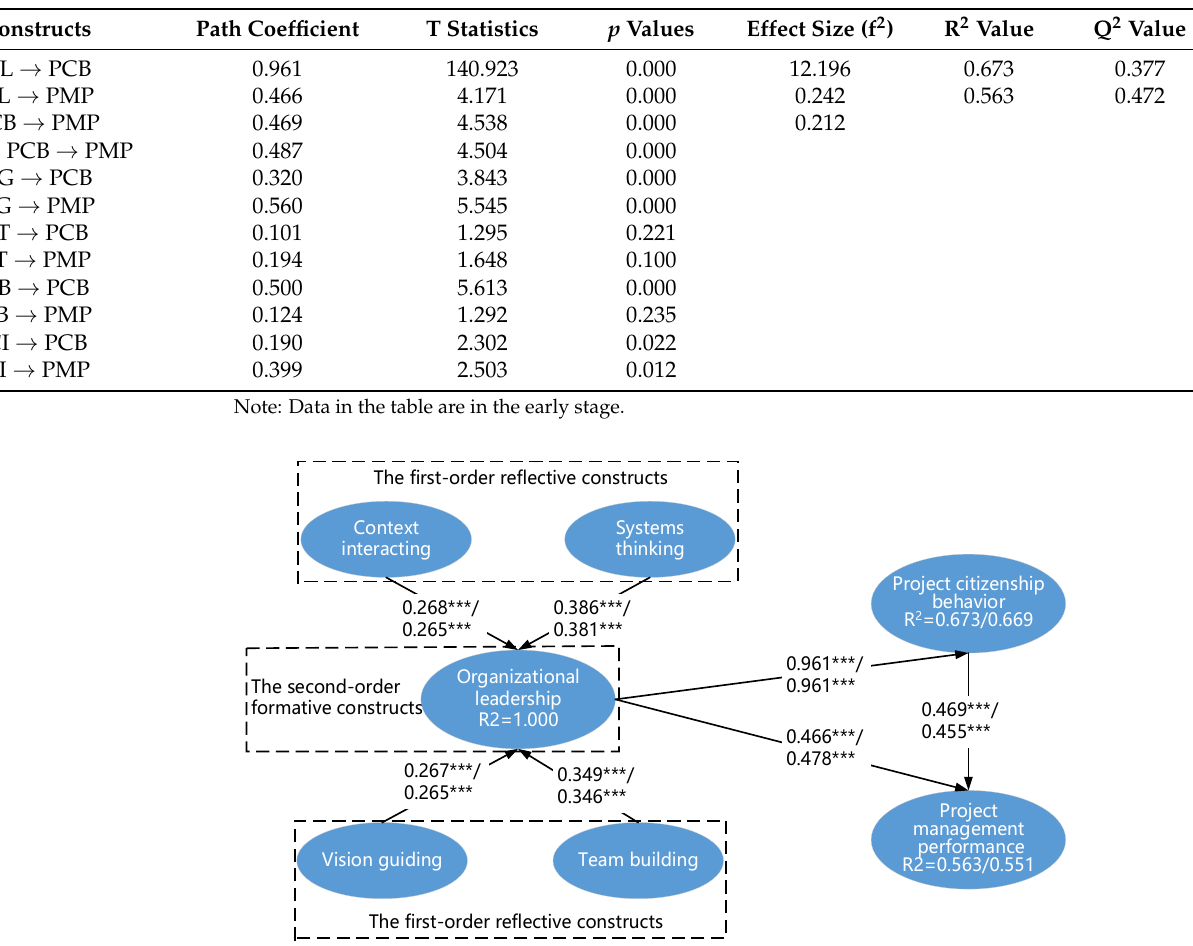
Figure 4. The structural model with analysis results. Notes: The early stage/the middle and late stages. *** p <